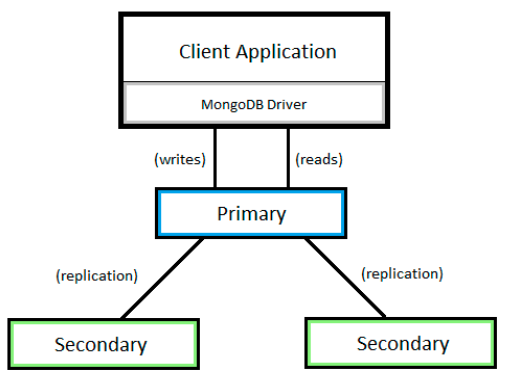
Figure 3. Replica set in MongoDB.